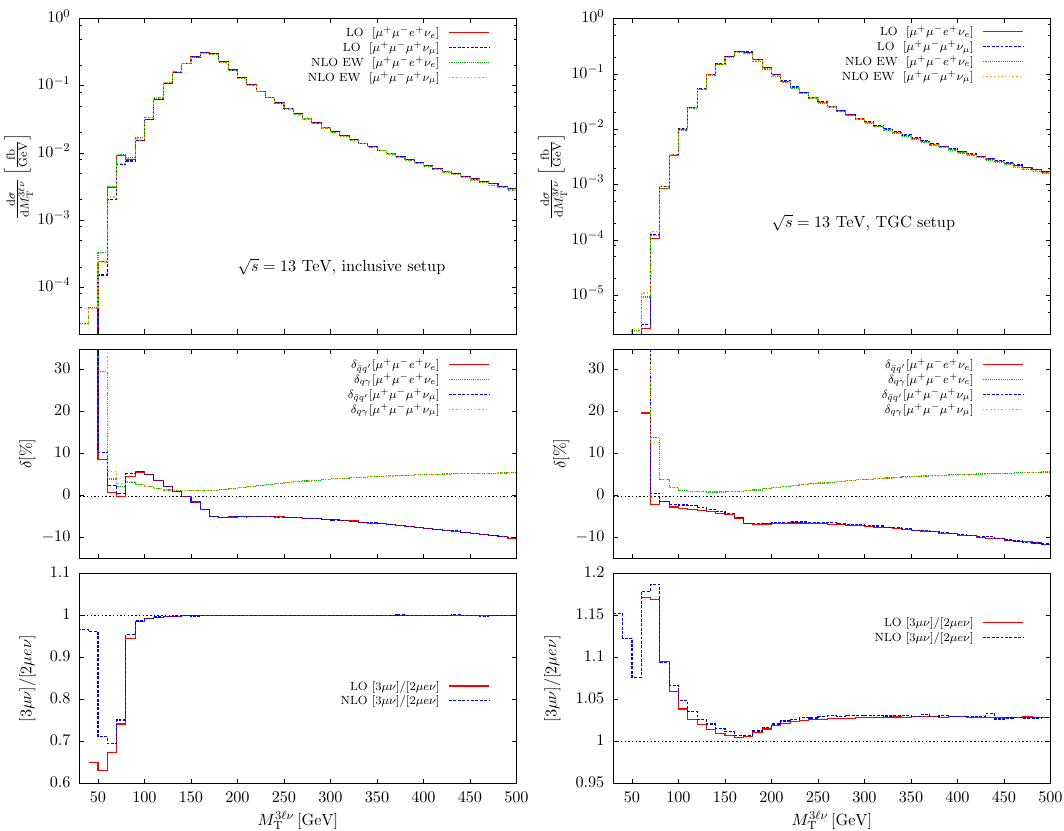
Figure 4 . Comparison between equal-flavour and mixed-flavour final state for the distribution in the four-lepton transverse mass M 3 ℓν for ZW + production. The left panel shows the inclusive T setup, the right panel the TGC